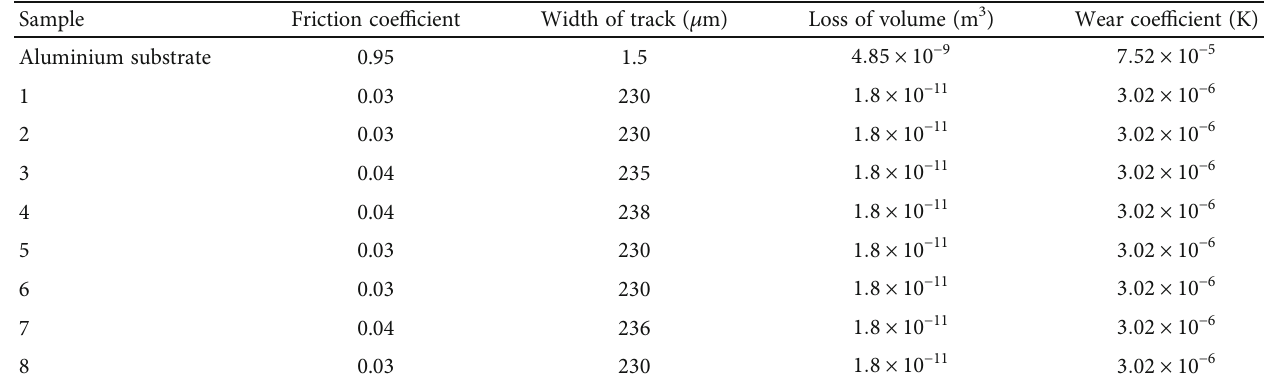
Table 3: Wear test results of coatings.